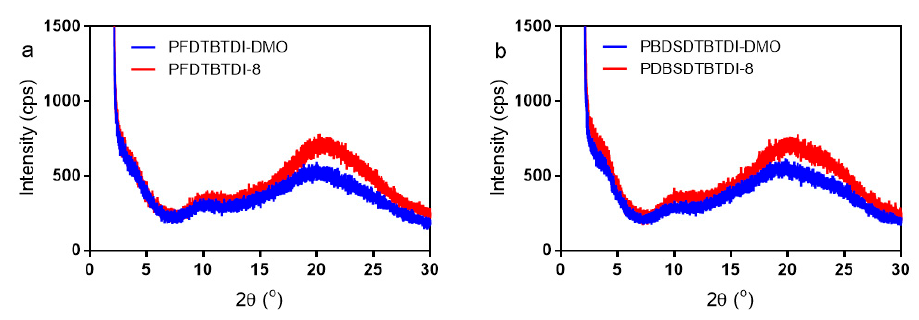
Figure 4. Powder XRD of ( a ) PFDTBTDI-DMO and PFDTBTDI-8; ( b ) PDBSDTBTDI-DMO and PDBSDTBTDI-8.